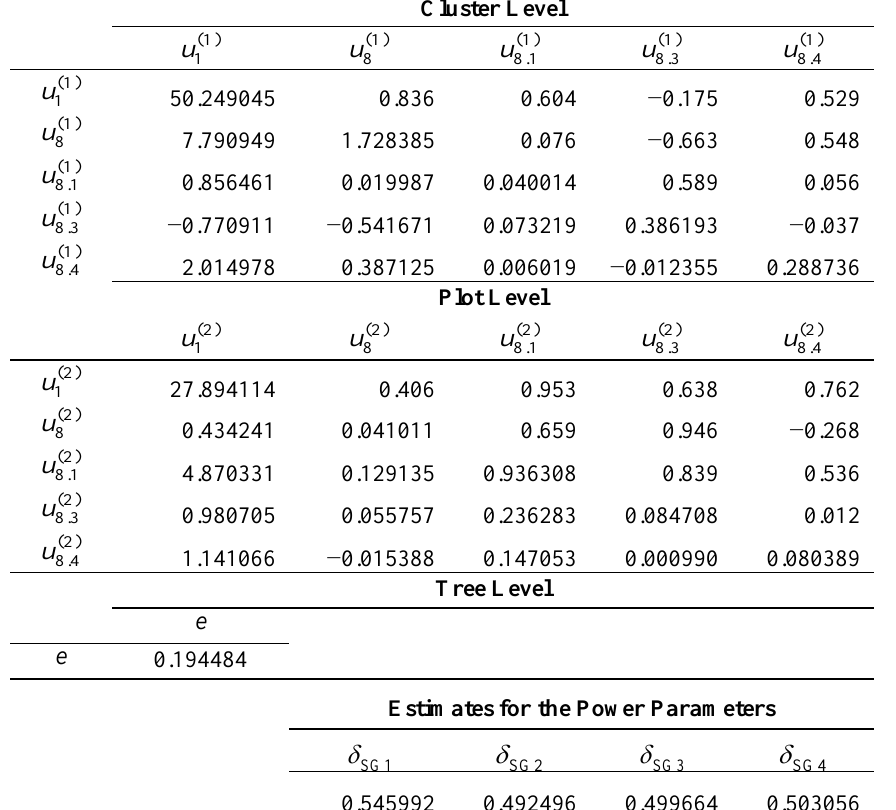
Table A3. Estimated Variances (diagonal), covariances (lower triangle) and correlations (upper triangle) for the random parameters of Equation (A1) at the cluster, plot and tree levels, respectively, and estimates for the power parameters of the variance function respective to the four species groups, i.e. , SG1–SG4 (Equation